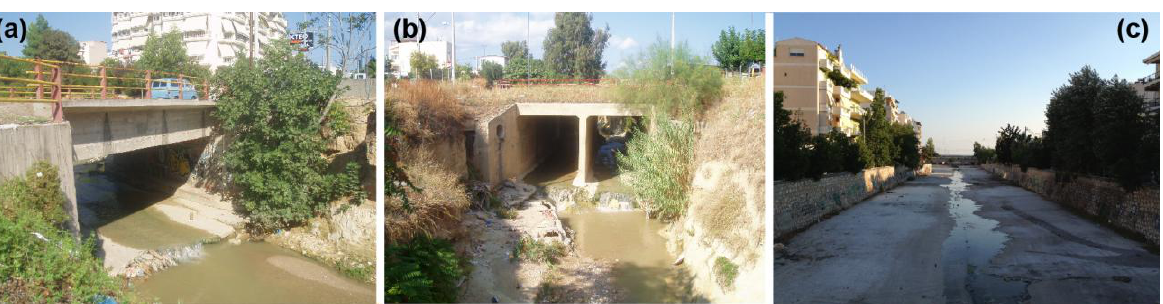
Figure 2. Typical examples of the condition of the drainage network in Athens including ( a ) cases of reduced cross sectional area due to bridge construction, ( b ) torrents covered or converted into streets and ( c ) buildings built directly alongside the riverbed in flood-prone